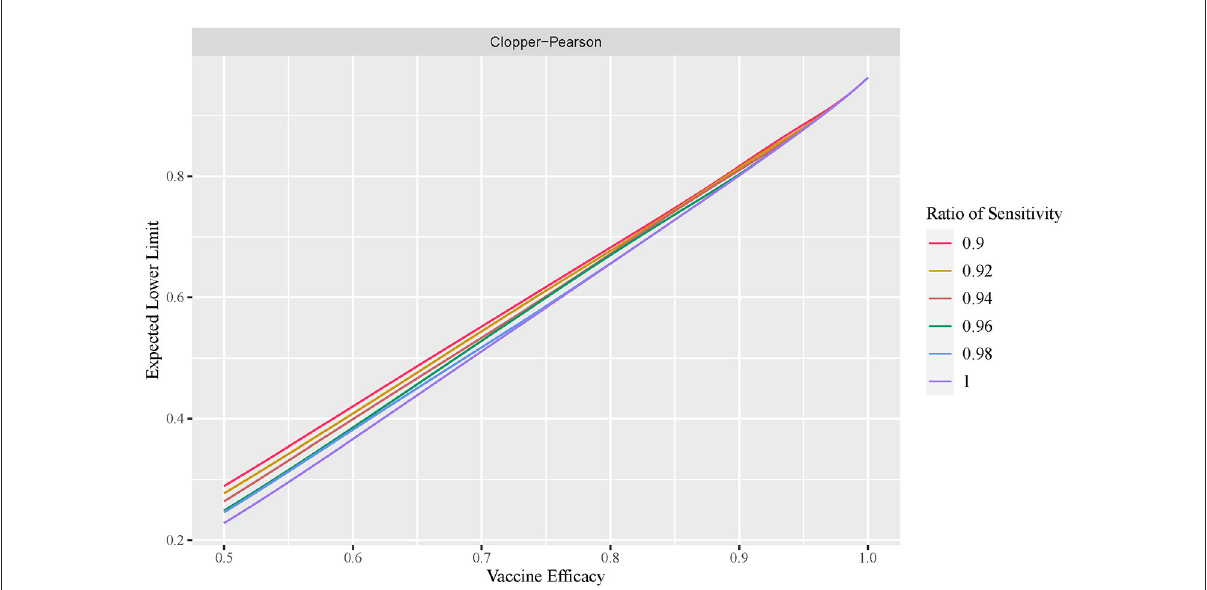
FIGURE5 Expected lower limit of observed VE interval with variable ratio of sensitivity (exact conditional